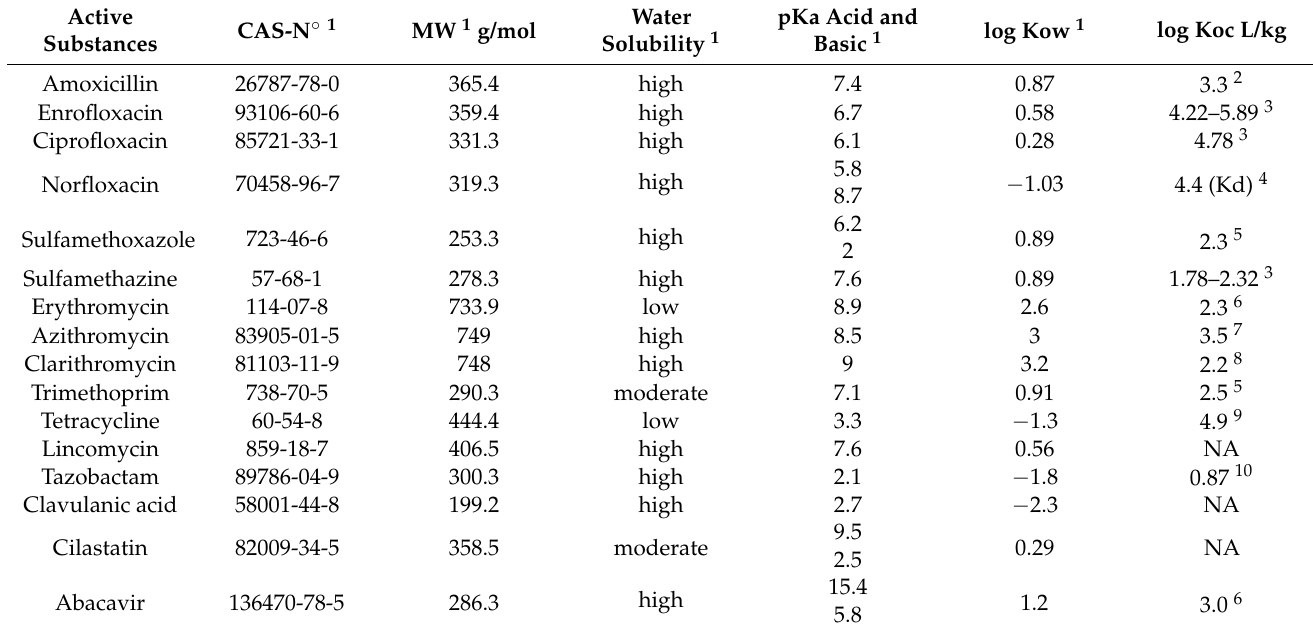
Table 2. Physicochemical properties of detected